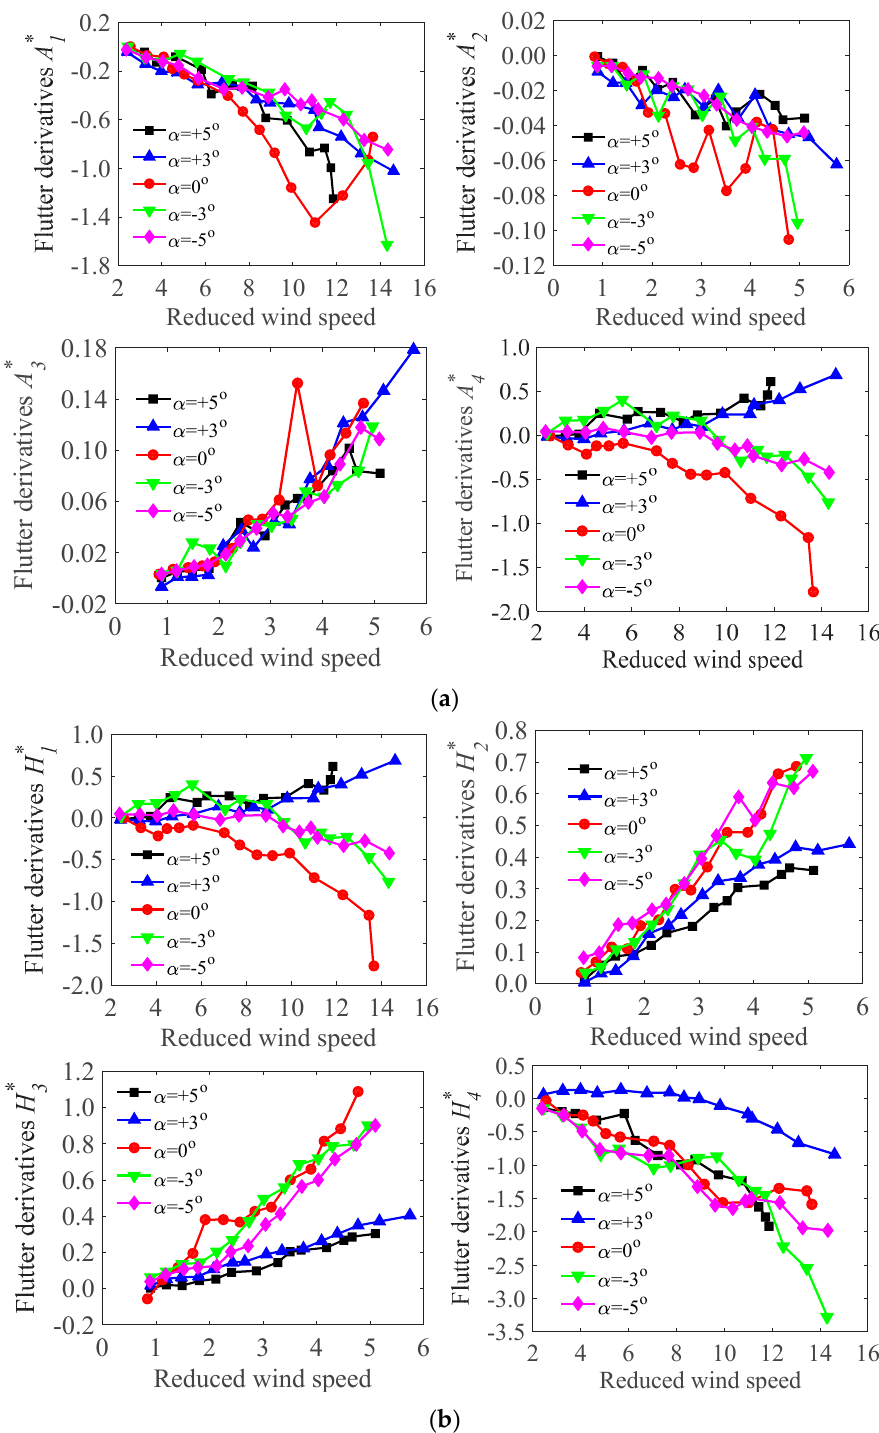
Figure 9. The flutter derivatives of the test model under different wind attack angles in the construction stage: ( a ) flutter derivatives A ∗